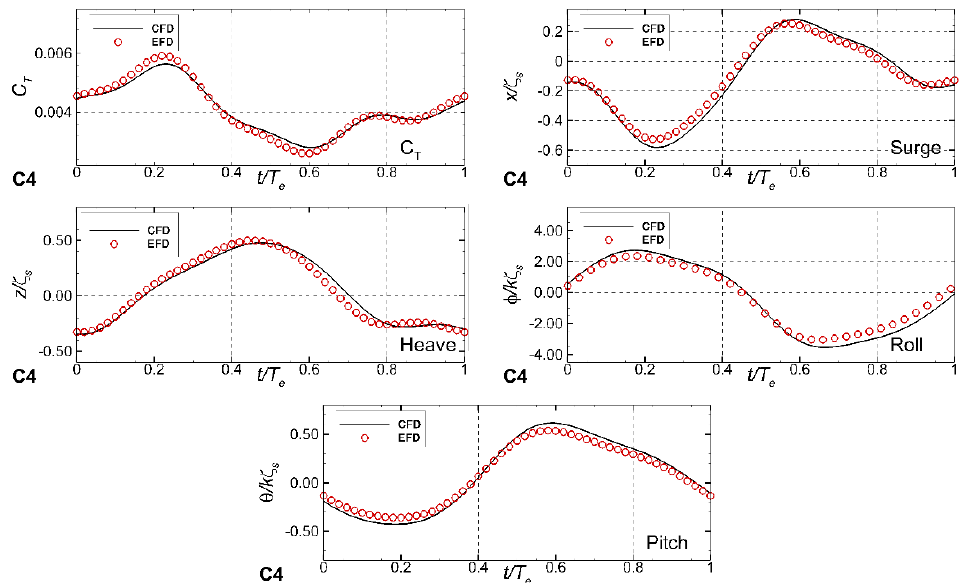
Figure 25. Comparisons between the time histories of the reconstructed resistance coefficient ( C T ) , surge ( x ) , heave ( z ) , roll ( ϕ ) , and pitch ( θ ) measured (EFD) [33], and computed (CFD) over a period of the encounter in the FRxz ϕθ quartering waves scenario.